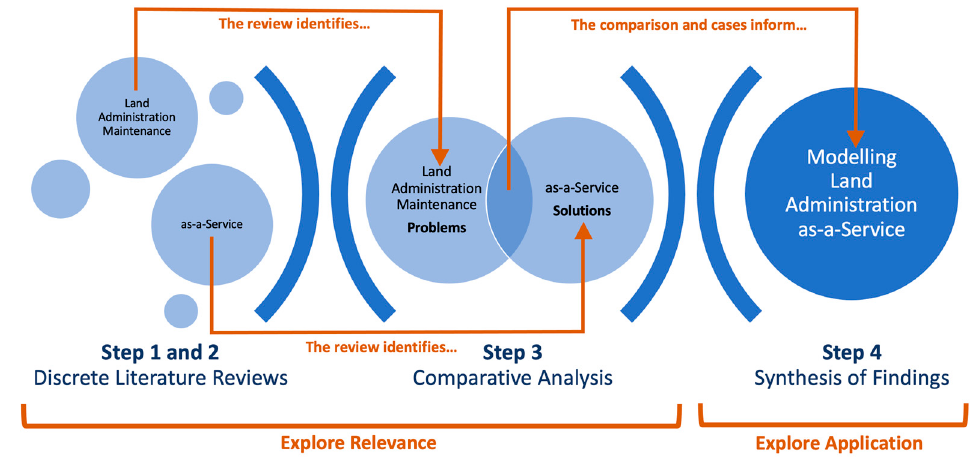
Figure 1. Research Workflow.